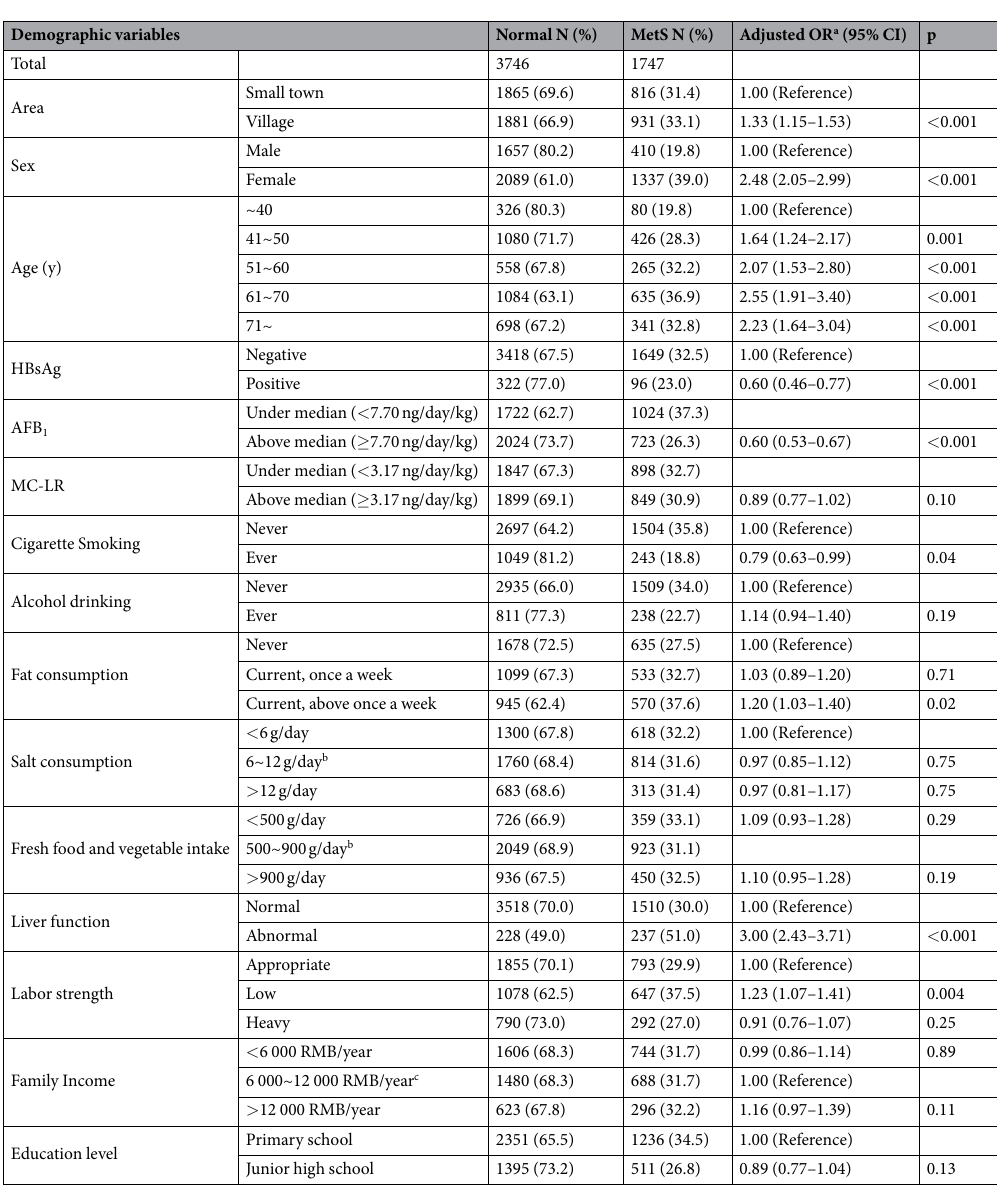
Table 1. Sociodemographic characteristics of subjects with and without MetS in rural areas located in Southwest China, 2013 (n = 5493). a The adjusted ORs were estimated by a binary logistic regression model that included sex, age, HBV infection, AFB1 exposure (EDI), MC-LR exposure (EDI), cigarette smoking, alcohol drinking, fat consumption, salt consumption, liver function, labor strength, family income and education level, except for the factors that had potential modification effects on MetS; b Recommended daily intake; c Average family income